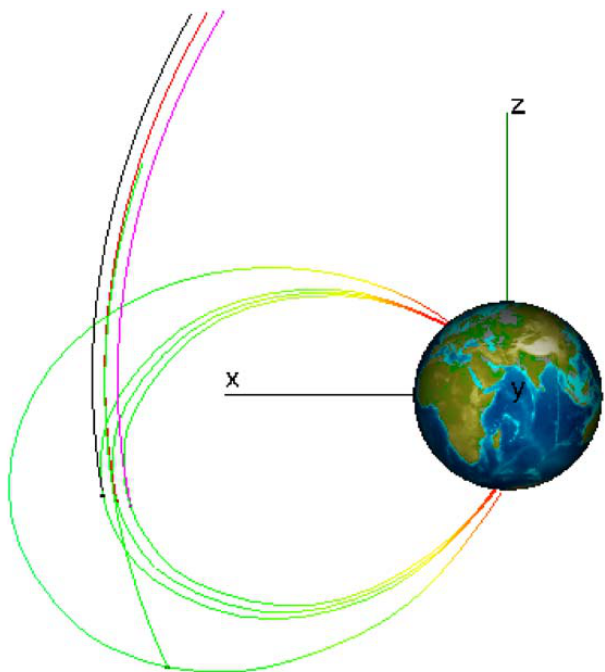
Fig. 1. Illustration of the spacecraft orbit in GSM coordinates. The spacecraft positions are shown at 14:10 UT and the field lines are traced using the T89 model. The orbits are drawn from 14:10 UT to 16:10 UT. Positive x is to the left; positive z up; and positive y is out of the papers